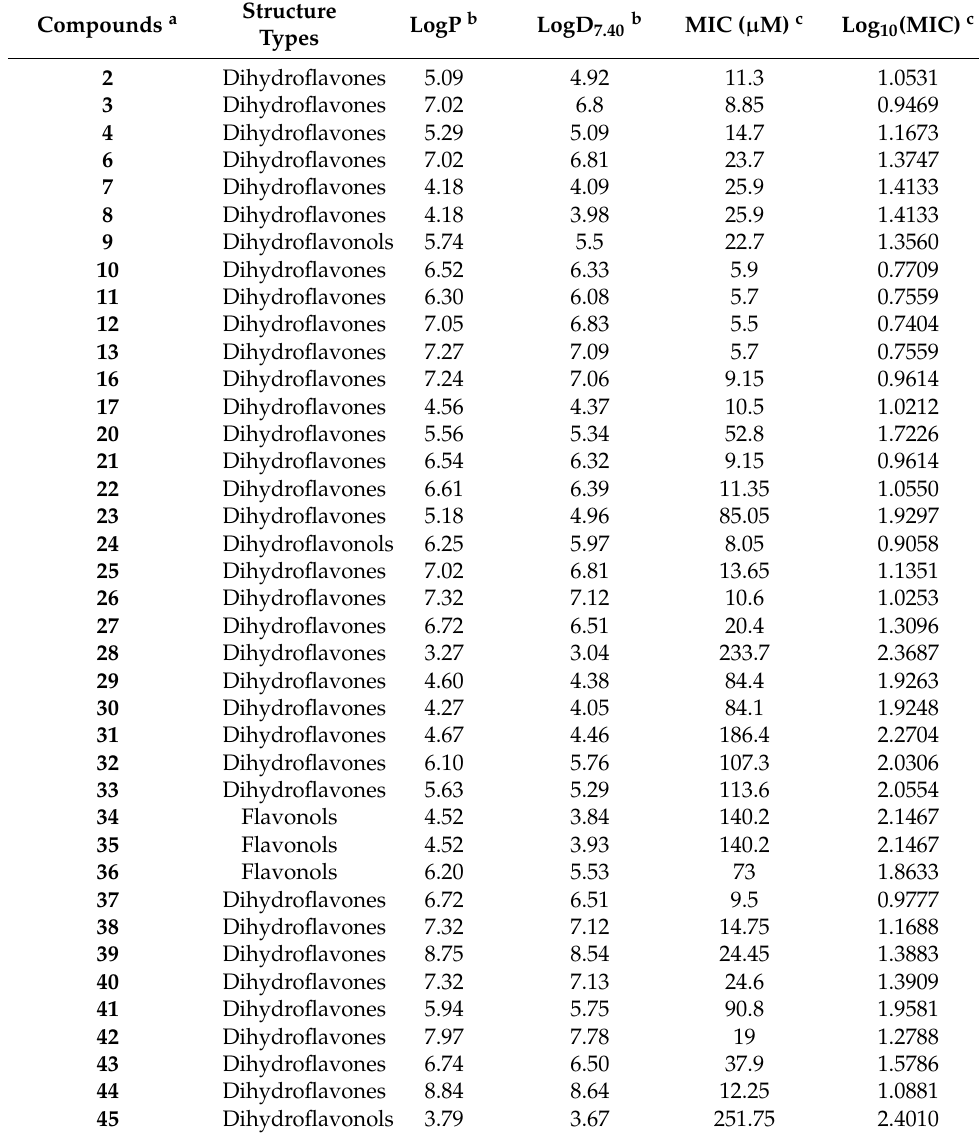
Table 1. Plant flavonoids together with their structure types, physicochemical parameters, and antimicrobial activities, used for the regression analyses